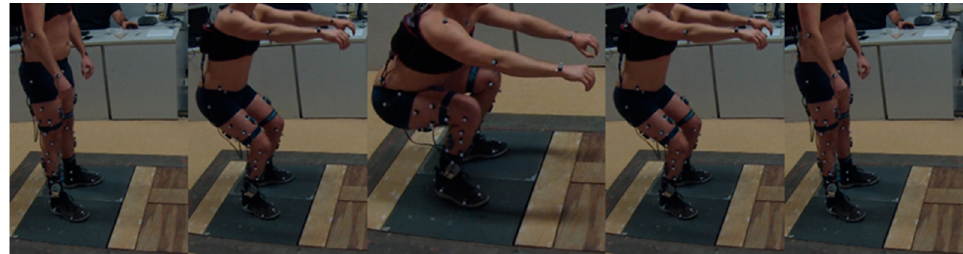
Figure 2. Stages of the bipodalic squat (left to right): (1) starting point, (2) descending phases, (3) peak flexion, (4), ascending phases, (5) return to starting point.